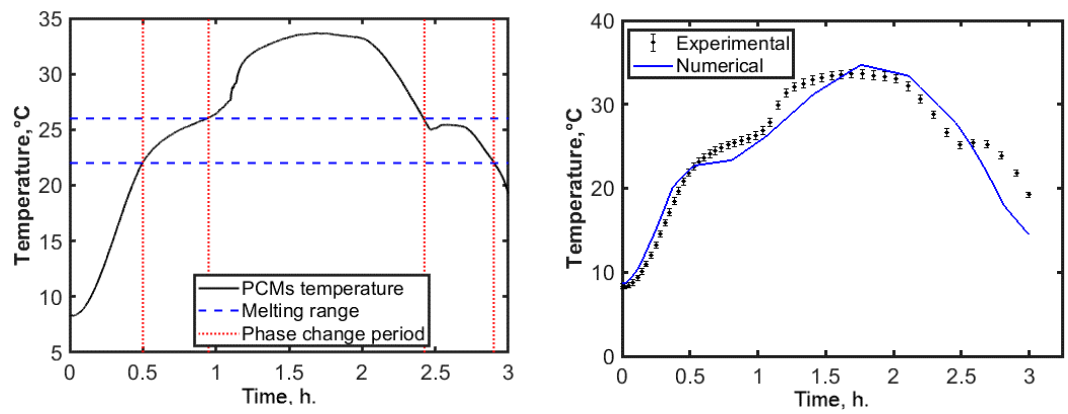
Figure 12. Phase change material temperature profiles.